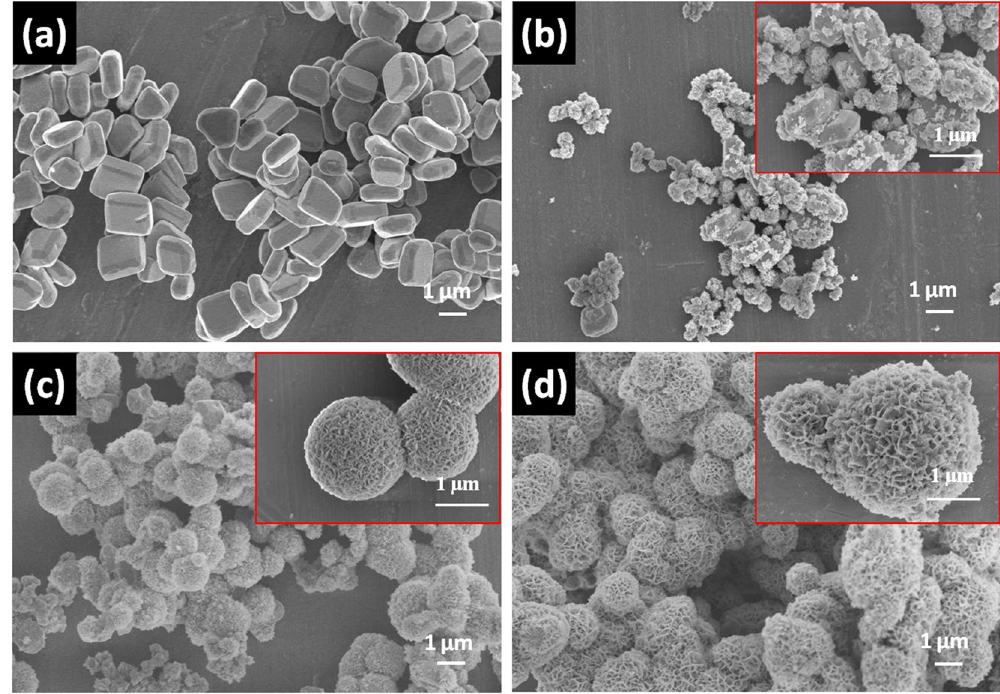
Figure 2. SEM images of the obtained Bi 2 Fe 4 O 9 samples with different etching times: ( a ) 0; ( b ) 15 min; ( c ) 30 min; ( d ) 45